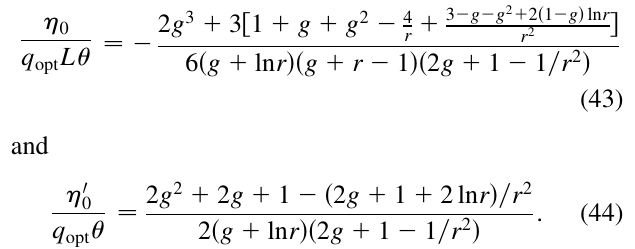
FIG. 16. Initial dispersion slope (cid:6) 0 emittance. The red curve is given by the approximate expression (cid:1) 0 : 281 (cid:1) 0 : 122 (cid:12) þ 0 : 0105 (cid:12) 2 (cid:1) 0 : 000 389 (cid:12) 3 þ 0 : 276 ln ½ k (cid:3) .